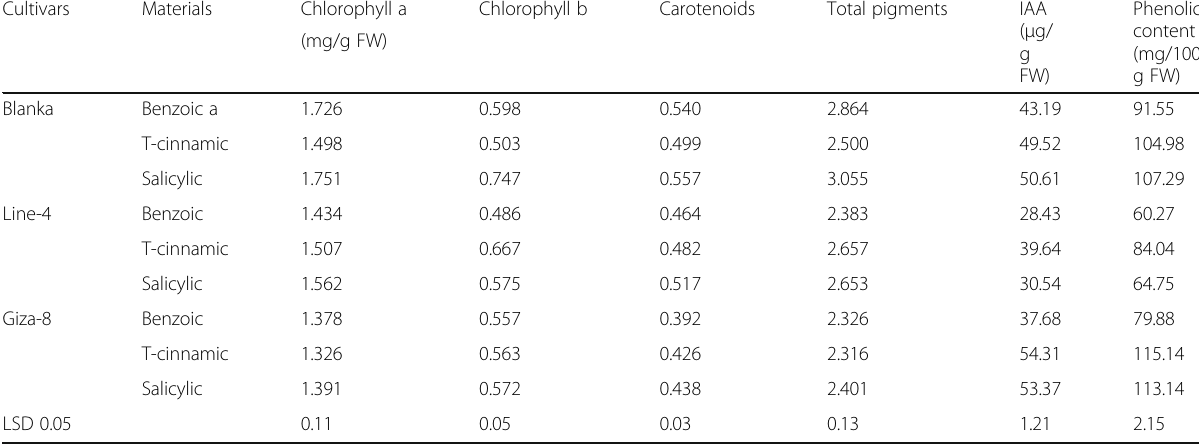
Table 12 Effect of cultivars and benzoic, t-cinnamic, and salicylic acids on photosynthetic pigments, IAA, and phenolic contents of flax plants grown under sandy soil conditions (data are means of two successive seasons) Cultivars